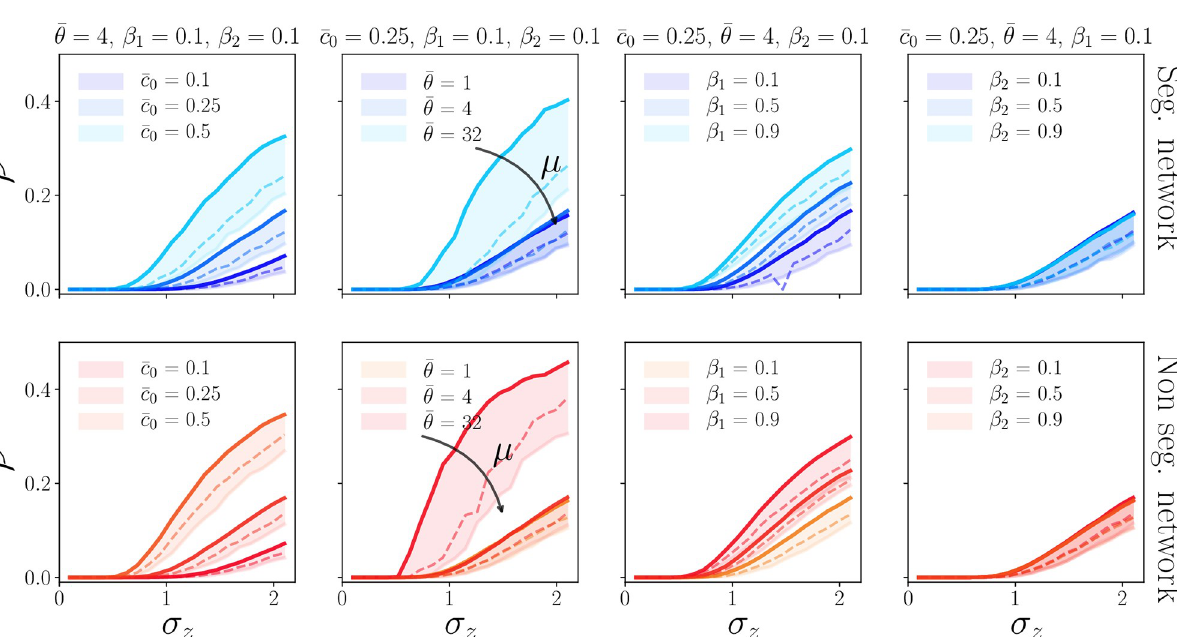
PLOS ONE | https://doi.org/10.1371/journal.pone.0261423 December20,